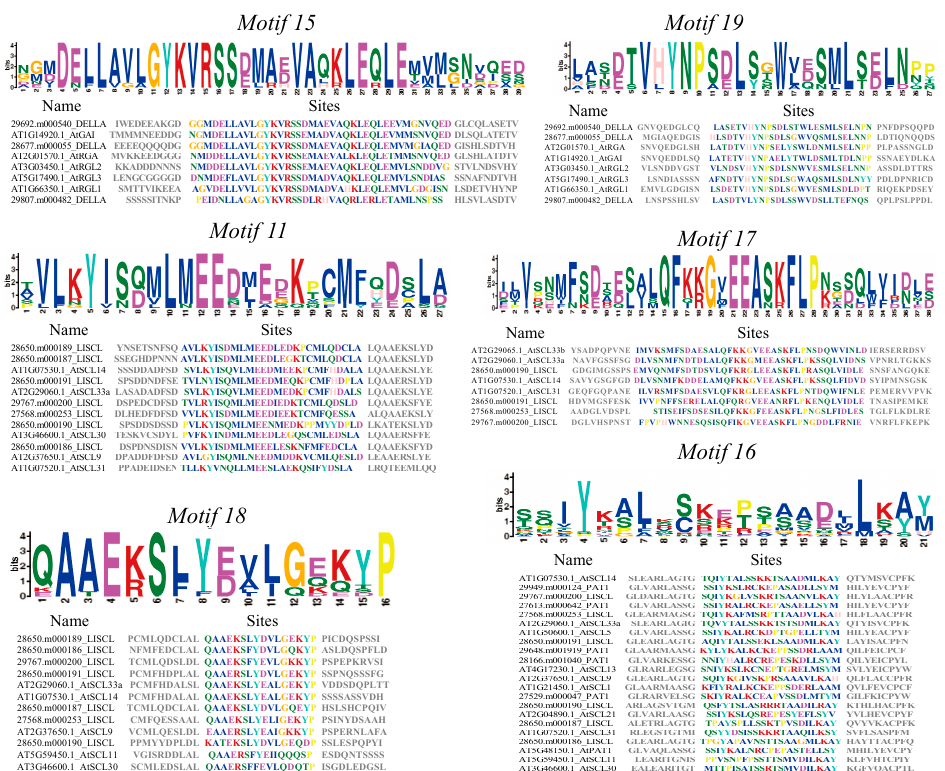
Figure 3. Subfamily-specific motifs nested in the N-terminus region of GRAS proteins in castor beans. The logo represents conserved amino acids sequences between castor beans and Arabidopsis included in the motif. Heights of letters in the logo show the frequency of amino acids at that position ( above ). The aligned sequences and conserved amino acids for each motif (colored letters) are shown ( below ).